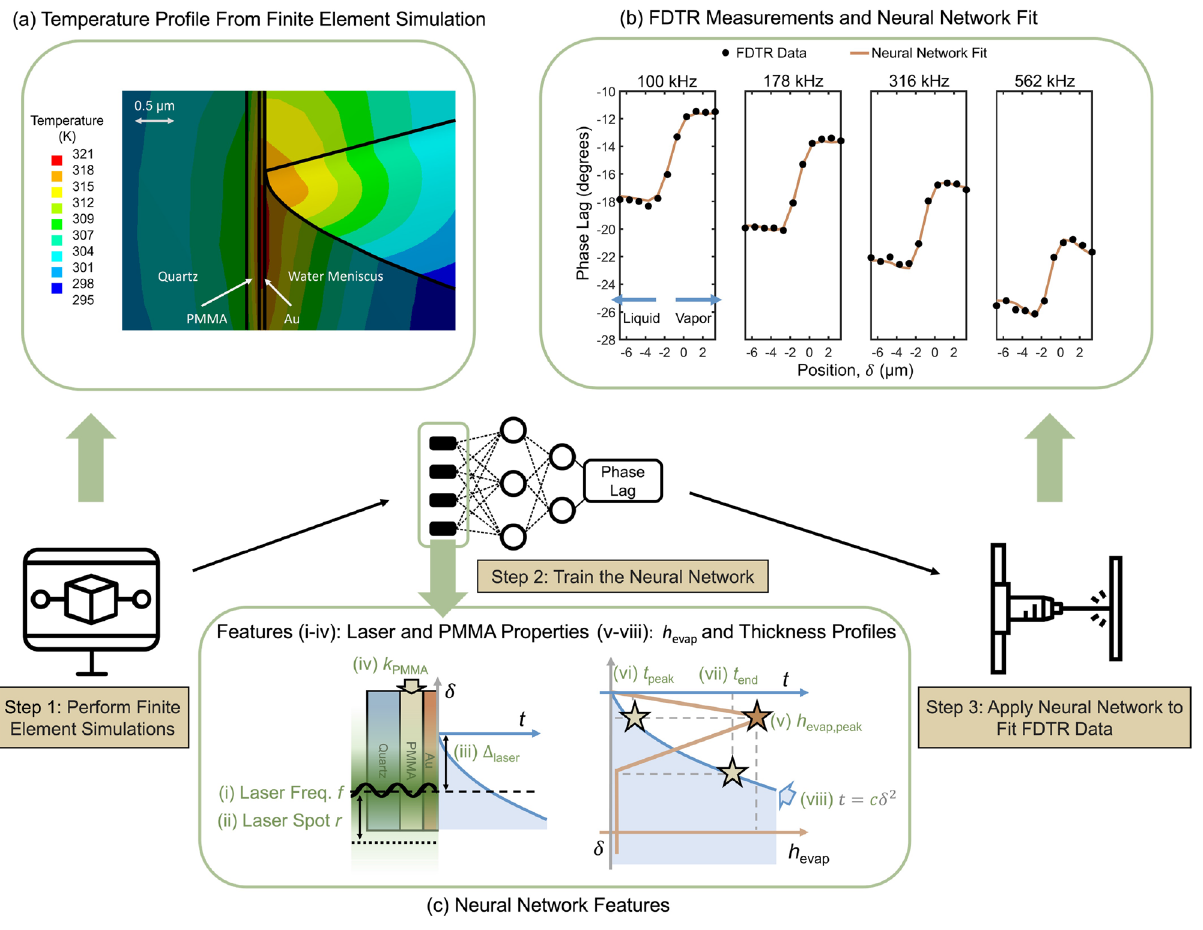
Figure 2. The three-step modeling framework includes finite element simulations, neural network training, and neural network fitting. ( a ) Finite element simulation of the temperature distribution in an FDTR experiment. The temperature increase is caused by a periodic heating and the phase lag is extracted from the spatially weighted gold temperature. ( b ) FDTR phase lag along the scanned region of the meniscus at four frequencies. The black circles are the measurements, obtained by scanning from the bulk liquid to the bulk vapor. The beige curves show the predictions from the trained neural network that minimize the mean square error. ( c ) The eight input features [(i)–(viii)] for the neural